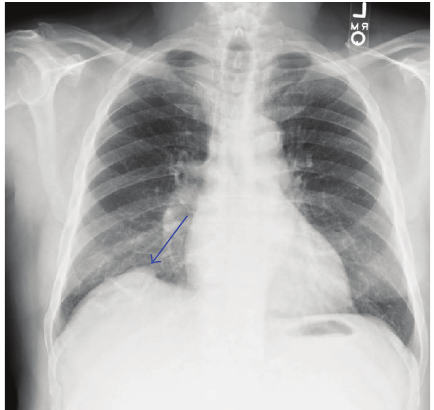
Figure 2: Chest X-ray illustrating the initial pulmonary infiltration of the liver mass (arrow).